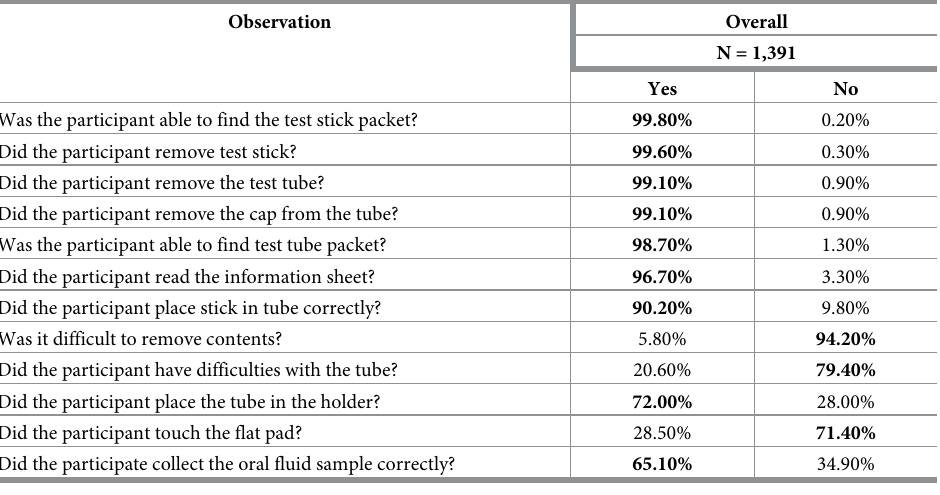
Table 3. Difficulties and errors observed during the self-test